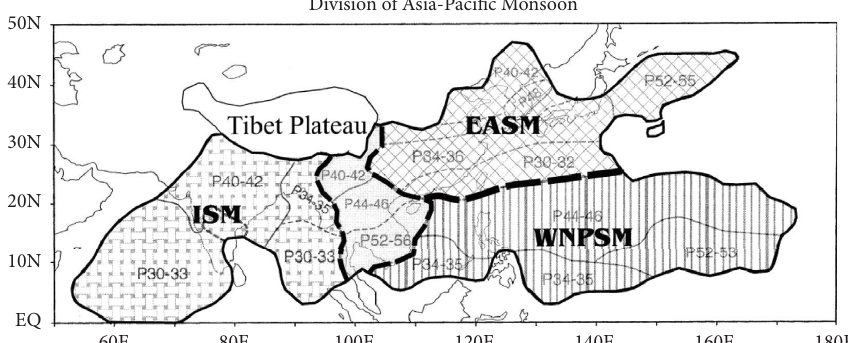
Figure 1: Map dividing the Asian-Pacifc monsoon into three subregions [1].